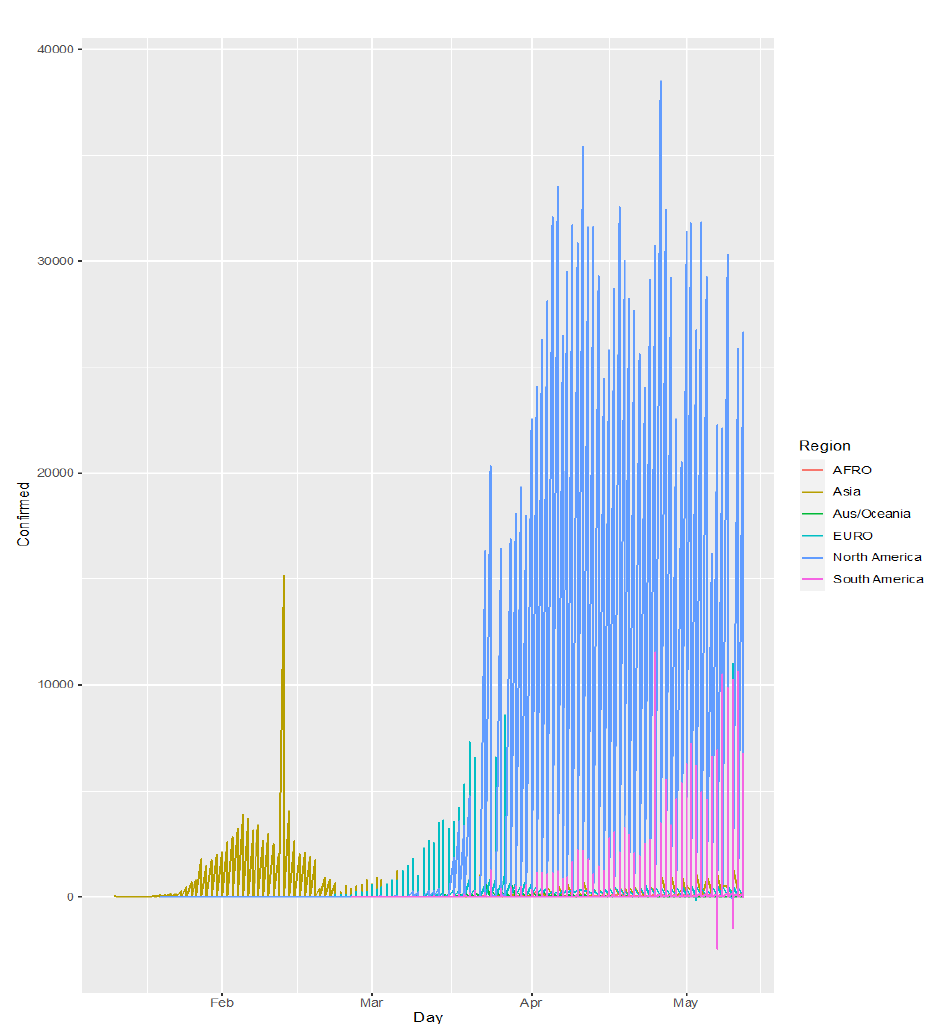
Fig. 2. Global simulation of COVID-19 confirmed cases by